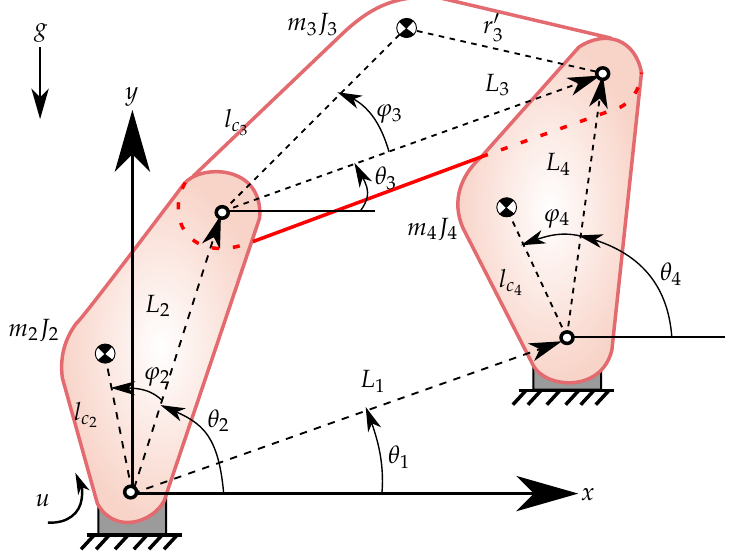
Figure 7. A scheme with parameters for a case of study in designing a four-bar